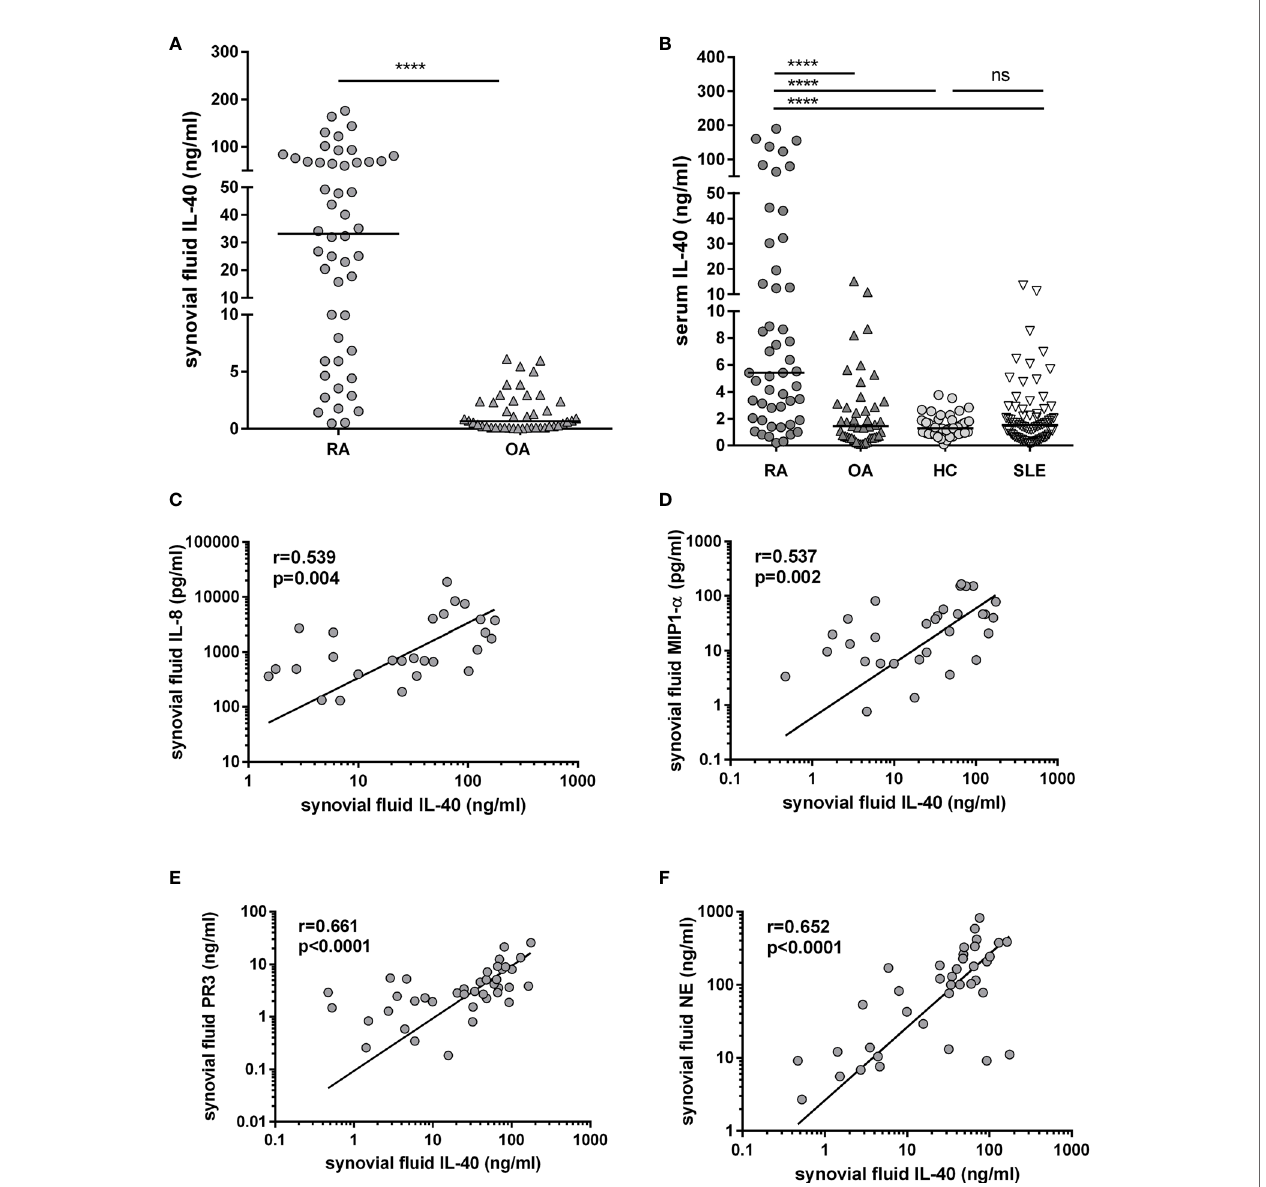
FIGURE 3 | Up-regulation of IL-40 in patients with rheumatoid arthritis (RA) and its association with the levels of chemokines and markers of NETosis. Levels of IL-40 in synovial fl uid are signi fi cantly higher in RA patients compared to osteoarthritis (OA) (A) . Levels of IL-40 in serum are elevated in RA patients compared to OA patients, healthy controls (HC), and patients with systemic lupus erythematosus (SLE) (B) . Synovial fl uid IL-40 signi fi cantly correlated with the levels of chemokines IL-8 (C) and MIP1- a (D) and with the markers of NETosis such as proteinase 3 (PR3) and neutrophil elastase NE (E, F) in the synovial fl uid of patients with RA. ****p < 0.0001; ns, nonsigni fi cant. The horizontal line represents the median. The association of IL-40 with chemokines was analysed using Spearman